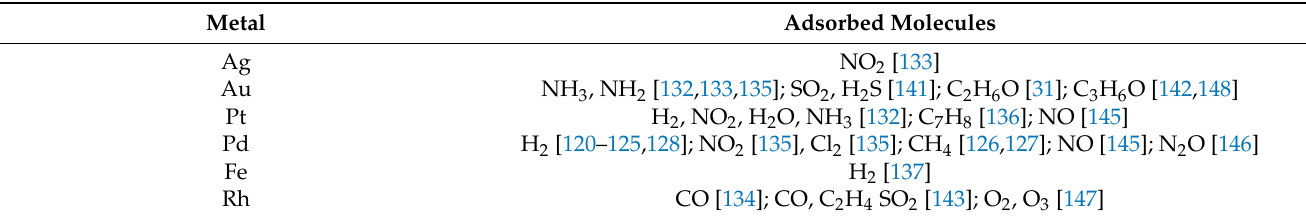
Table 6. List of transition metals used for doping carbon nanotubes and the corresponding adsorbed gases.